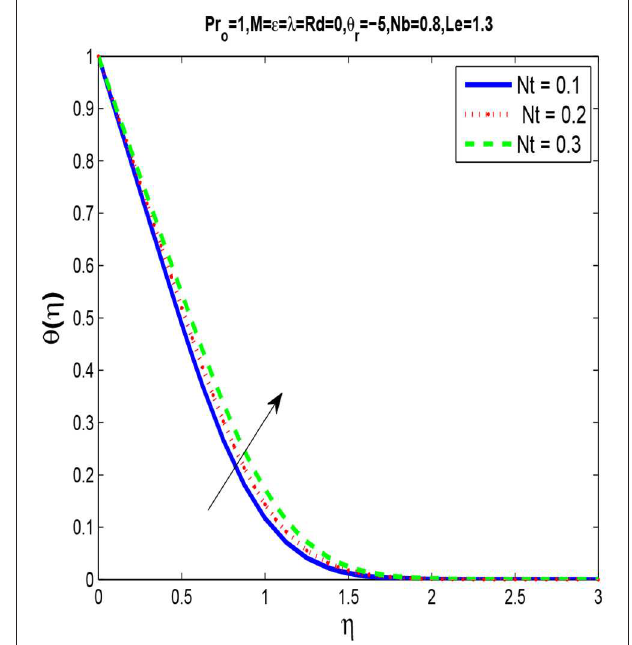
FIGURE 7 | Temperature profile θ ( η ) for different N t ( For Case B).